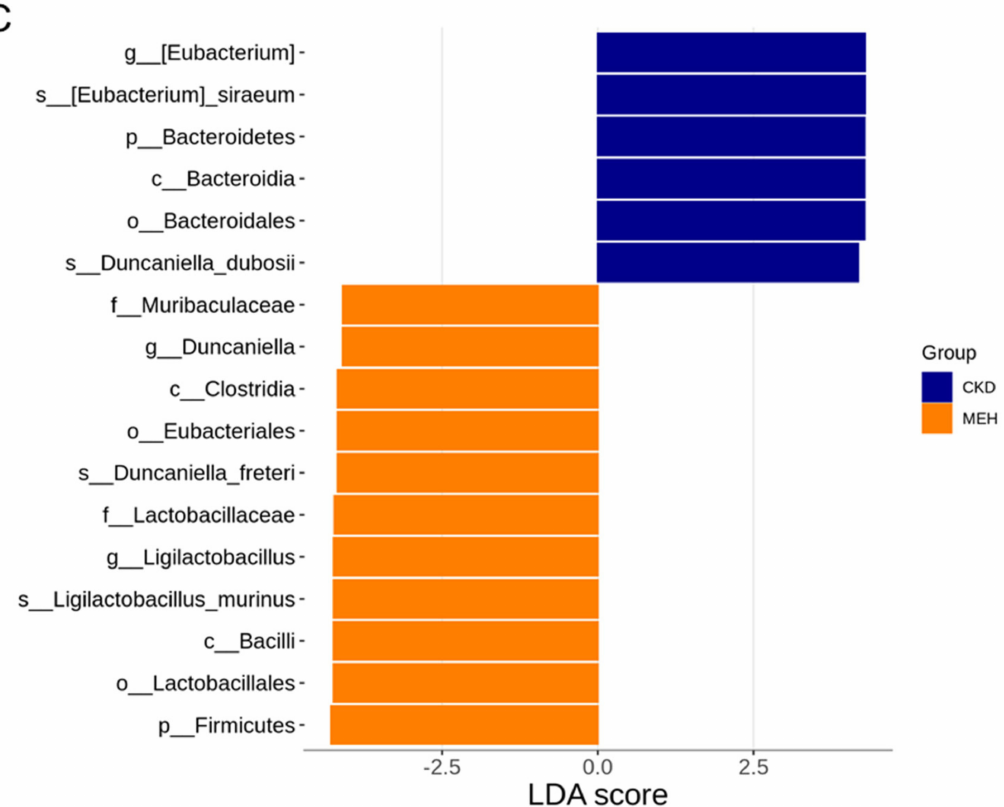
Figure 5. Linear discriminant analysis (LDA) along with effect-size measurements applied to present the most enriched and depleted taxa in: ( A ) the CN (blue) and CKD (orange) groups; ( B ) the CKD (blue) and MEL (orange) groups; and ( C ) the CKD (blue) and MEH (orange) groups. The LDA score threshold was set to greater than